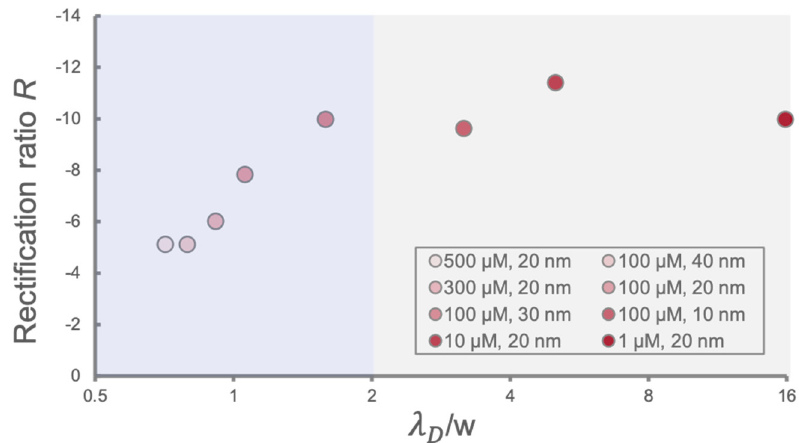
Figure 5. Plot of rectification ratios numerically obtained at various λ D /w values ( λ D /w is displayed in logarithmic scale). The legend denotes the respective ionic strength and pore size condition for each data point.